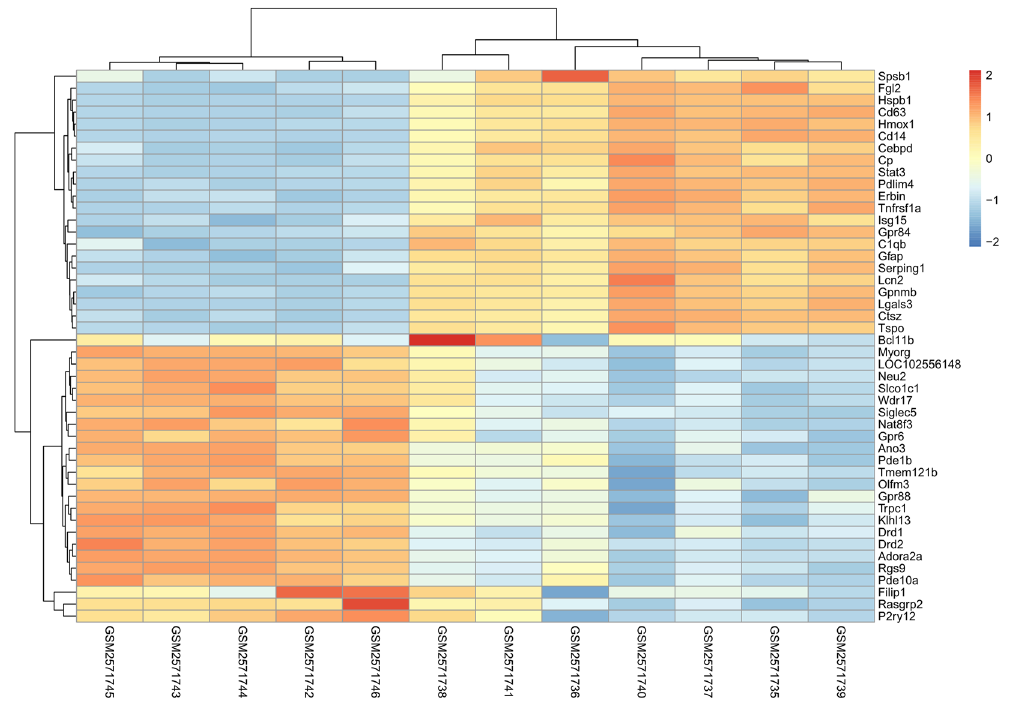
Figure 6. Heat map of DEMs. The left 5 samples were from Sham group, the right 7 samples were from MCAO group. The color from blue to red shows the progression from low expression to high expression.